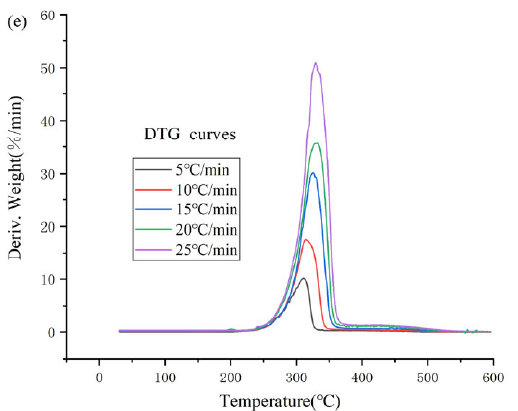
Figure 2. DTG curves of [Emmim][NO 3 ] ( a ), [Bmmim][NO 3 ] ( b ), [Hmmim][NO 3 ] ( c ), [Ommim][NO 3 ] ( d ) and [Dmmim][NO 3 ] ( e ) with different heating rates.